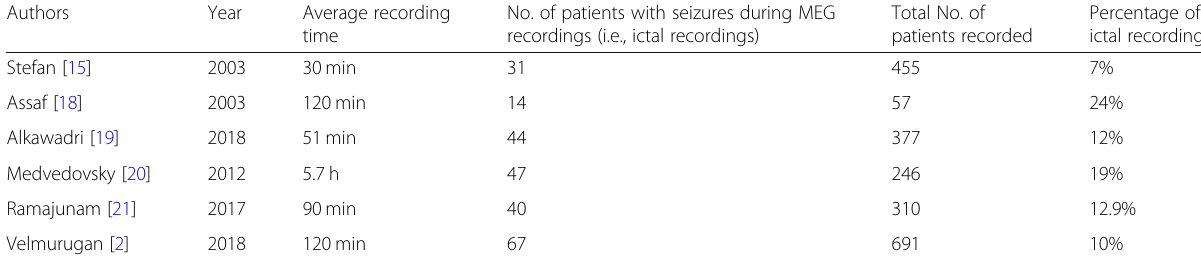
Table 1 Percentage of ictal recordings in different studies and average recording times Authors